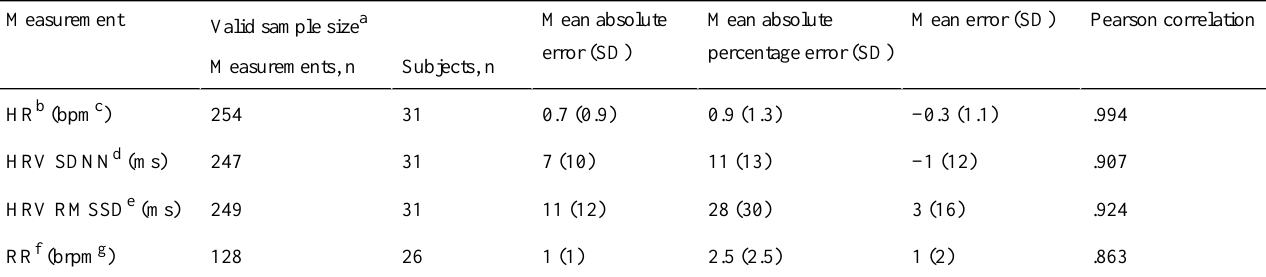
Table 3. The accuracy of the biometric estimates (mean, SD) of the Wavelet wristband compared with the reference electrocardiography and respirometer